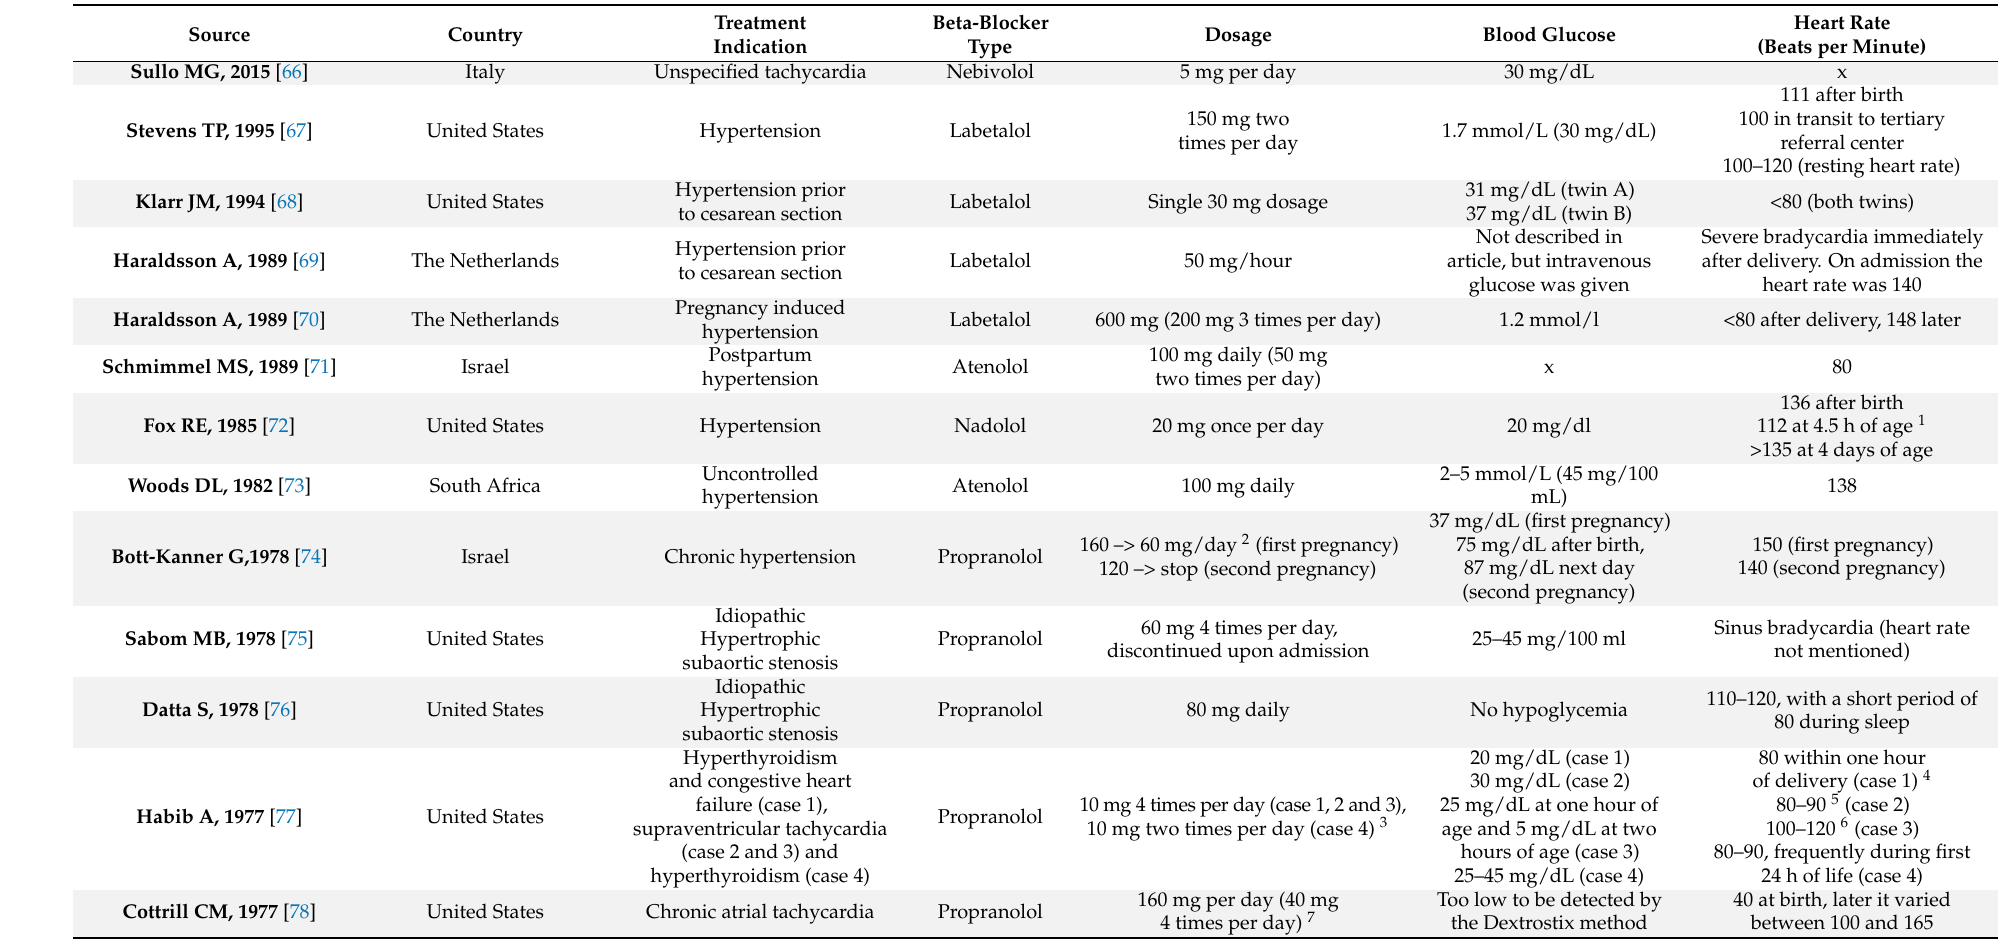
Table 11. Overview